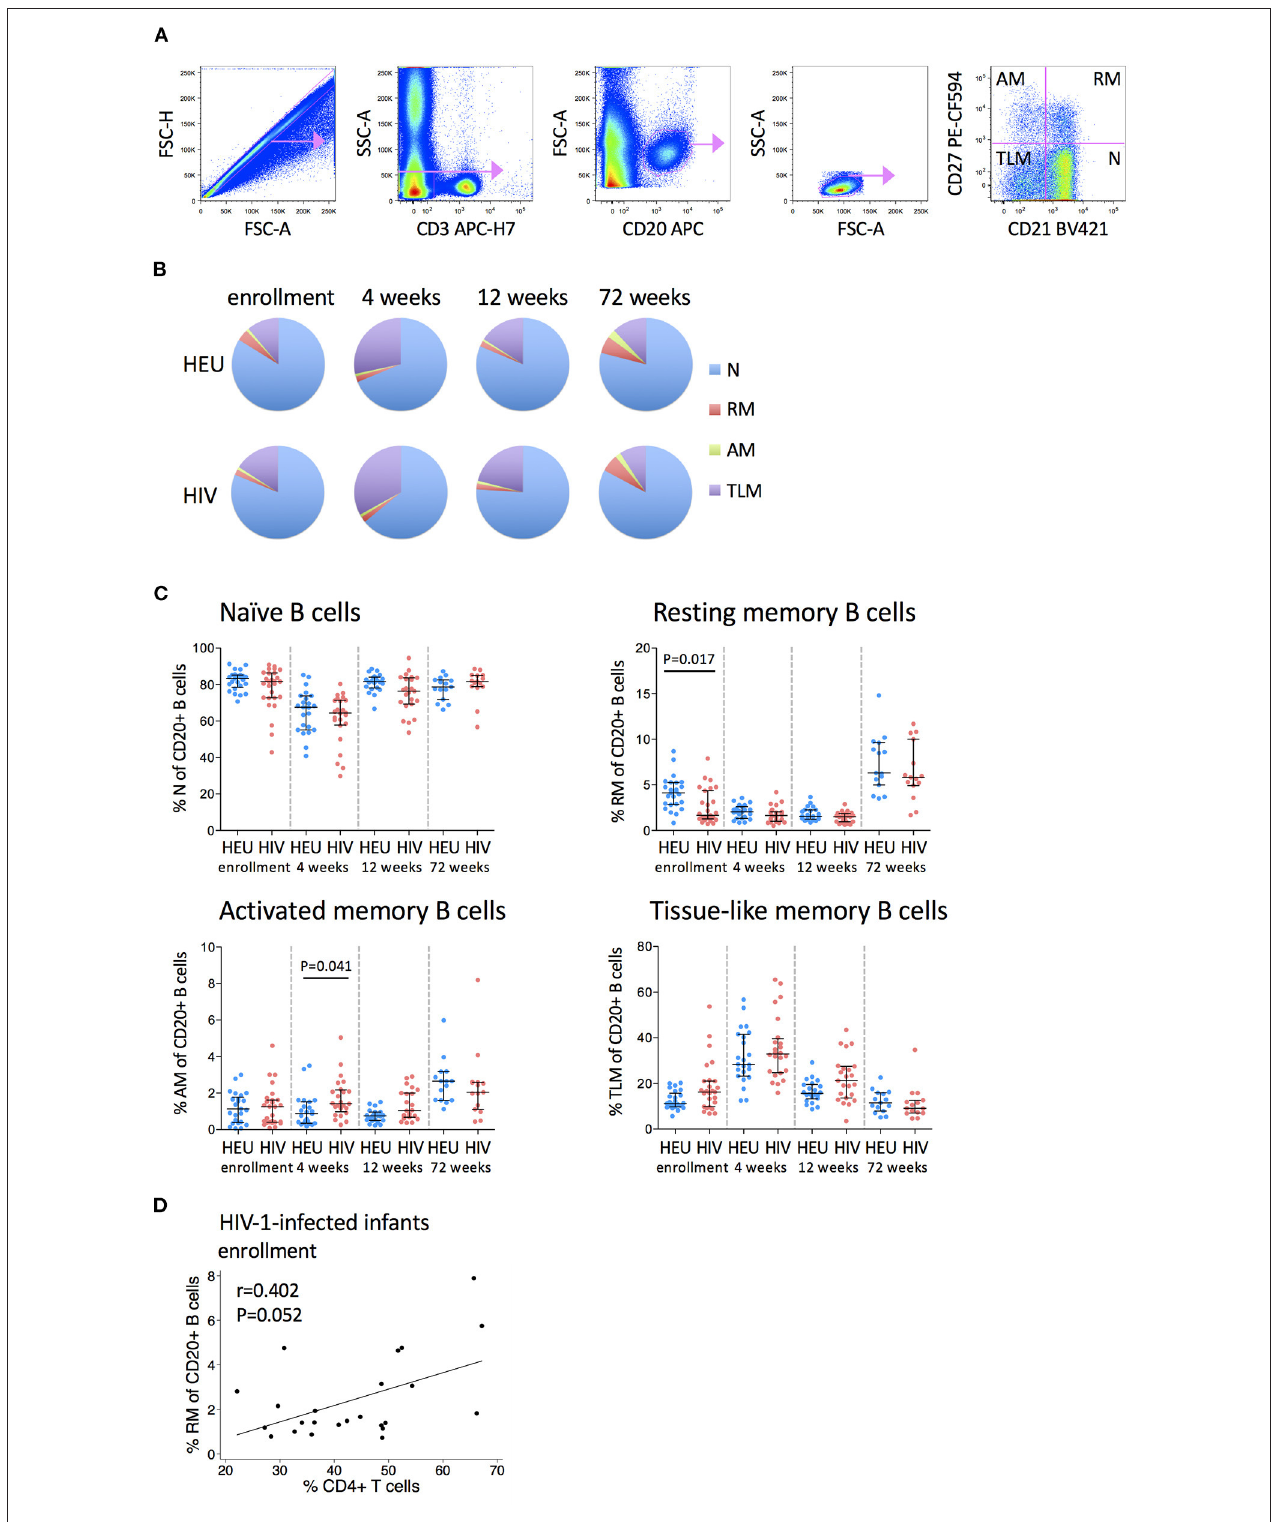
FIGURE 4 | Frequencies of B cell subsets are altered in HIV-1-infected infants. (A) Pseudocolor plots showing representative gating of B cell subsets. Singlets are identified using FSC-H against FSC-A. B cells are identified by CD20 gating of CD3- cells, followed by gating on low SSC-A vs. low FSC-A. B cell